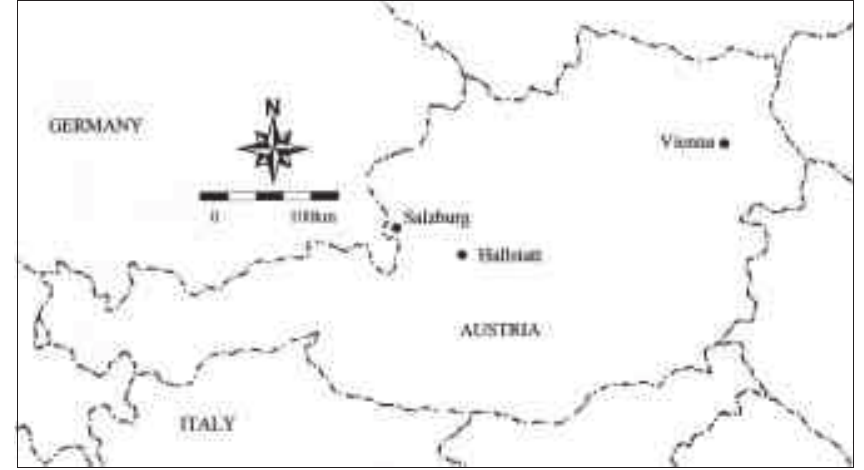
Figure 1 Location map showing the position of Hallstatt spills of fir that were used as torches,